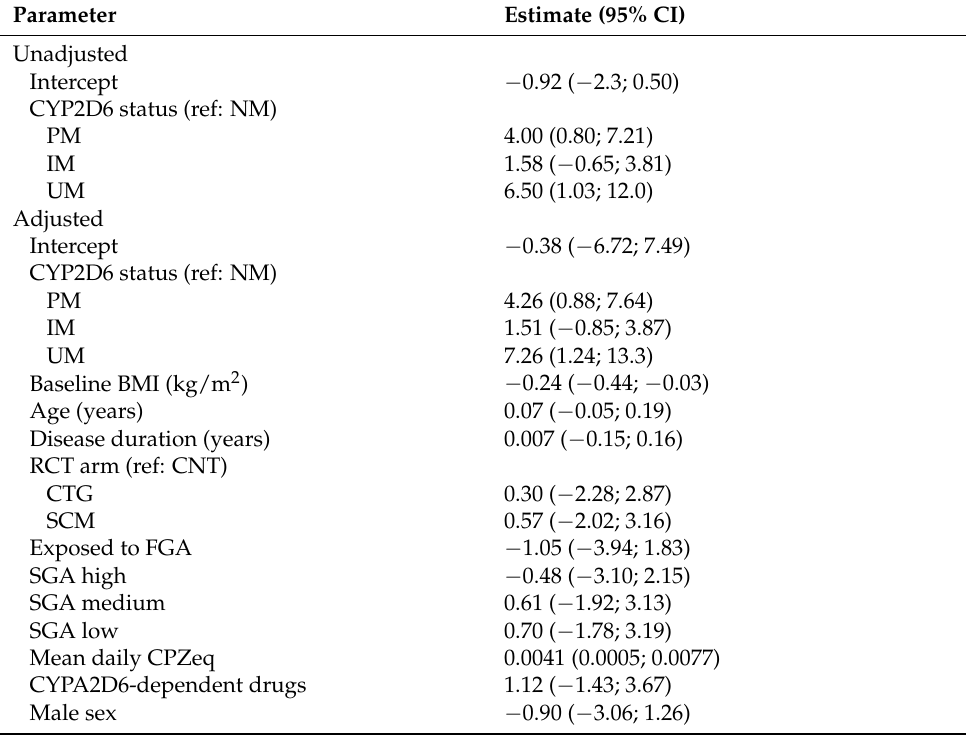
Table 4. Multiple linear regression. Average weight change.